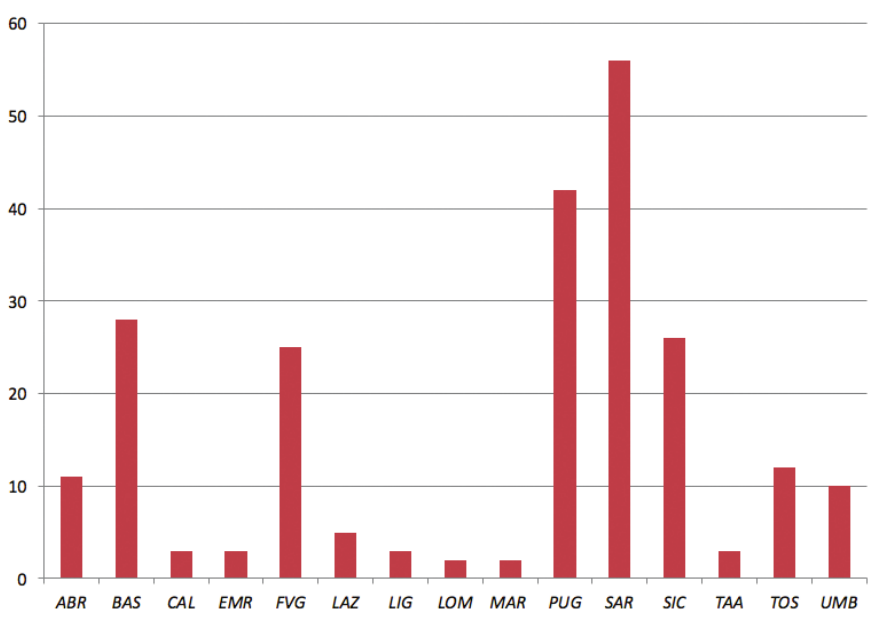
Figure 3. Number of exclusive wild taxa used as food for each